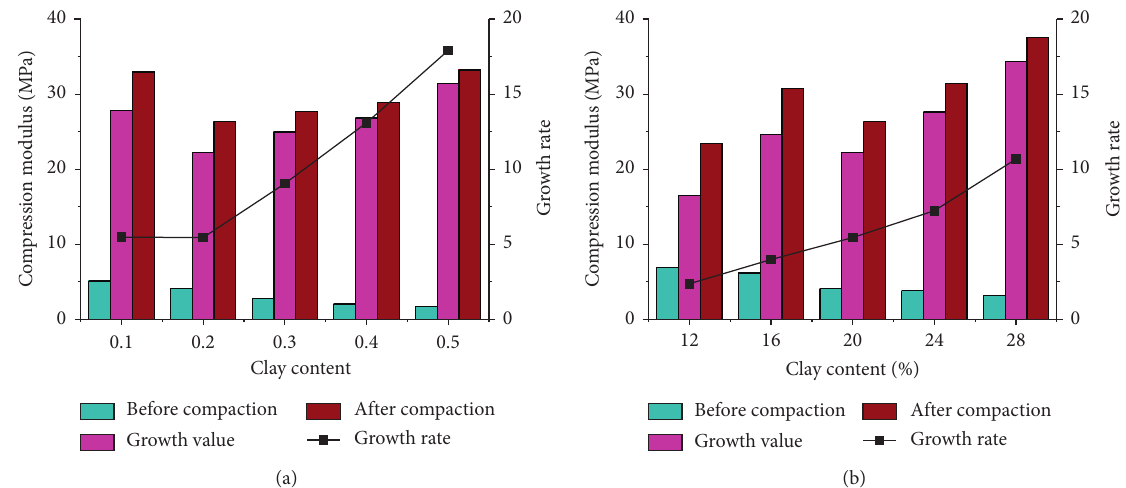
Figure 14: Comparison of compression modulus before and after compaction ( p � 2 MPa). (a) At different clay contents. (b) At different initial water